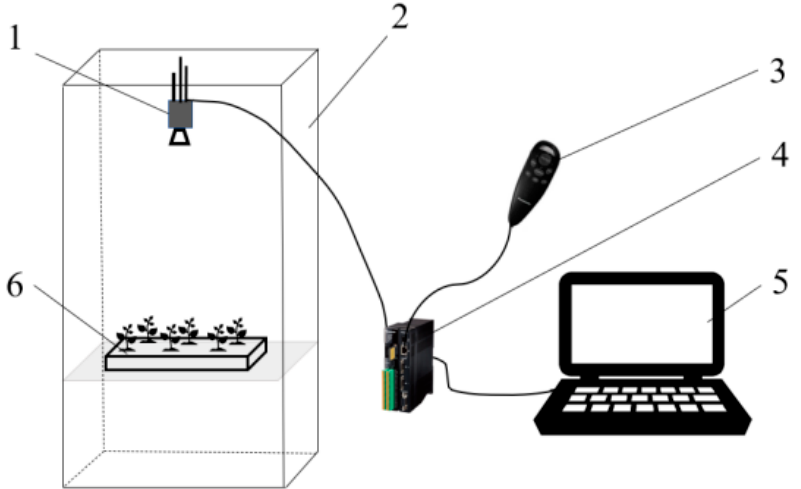
Figure 2. The composition of vision system: 1. Camera. 2. Stand. 3. Handle. 4. Controller. 5. Monitor.